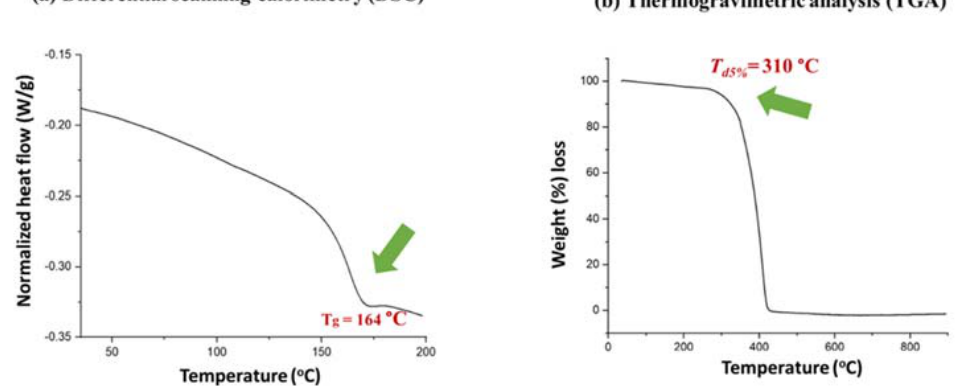
Figure 5. Characterization of thermal properties of PMBL (sample (C4 in Table 1) produced by iCVD at P m / P sat = 0.71; M n = 9289 g/mol and PDI = 2.08): ( a ) DSC: T g obtained from the exothermic peak of the second heating cycle and ( b ) TGA. Table 2. The effect of PMBL molar mass (M n ) on glass transition temperature (T g ).